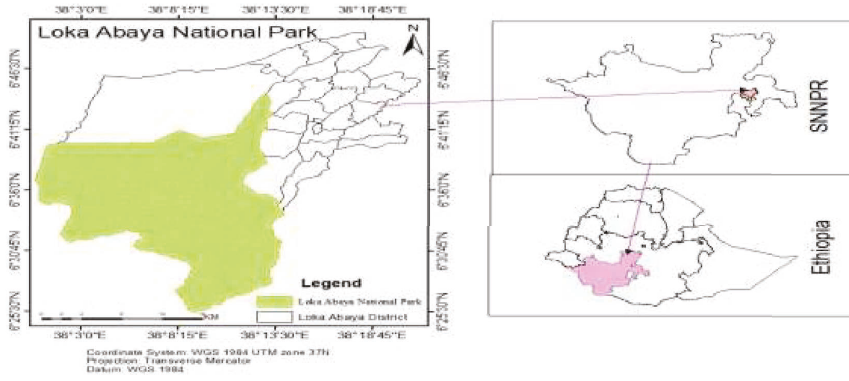
Figure 1: Map of the study area.